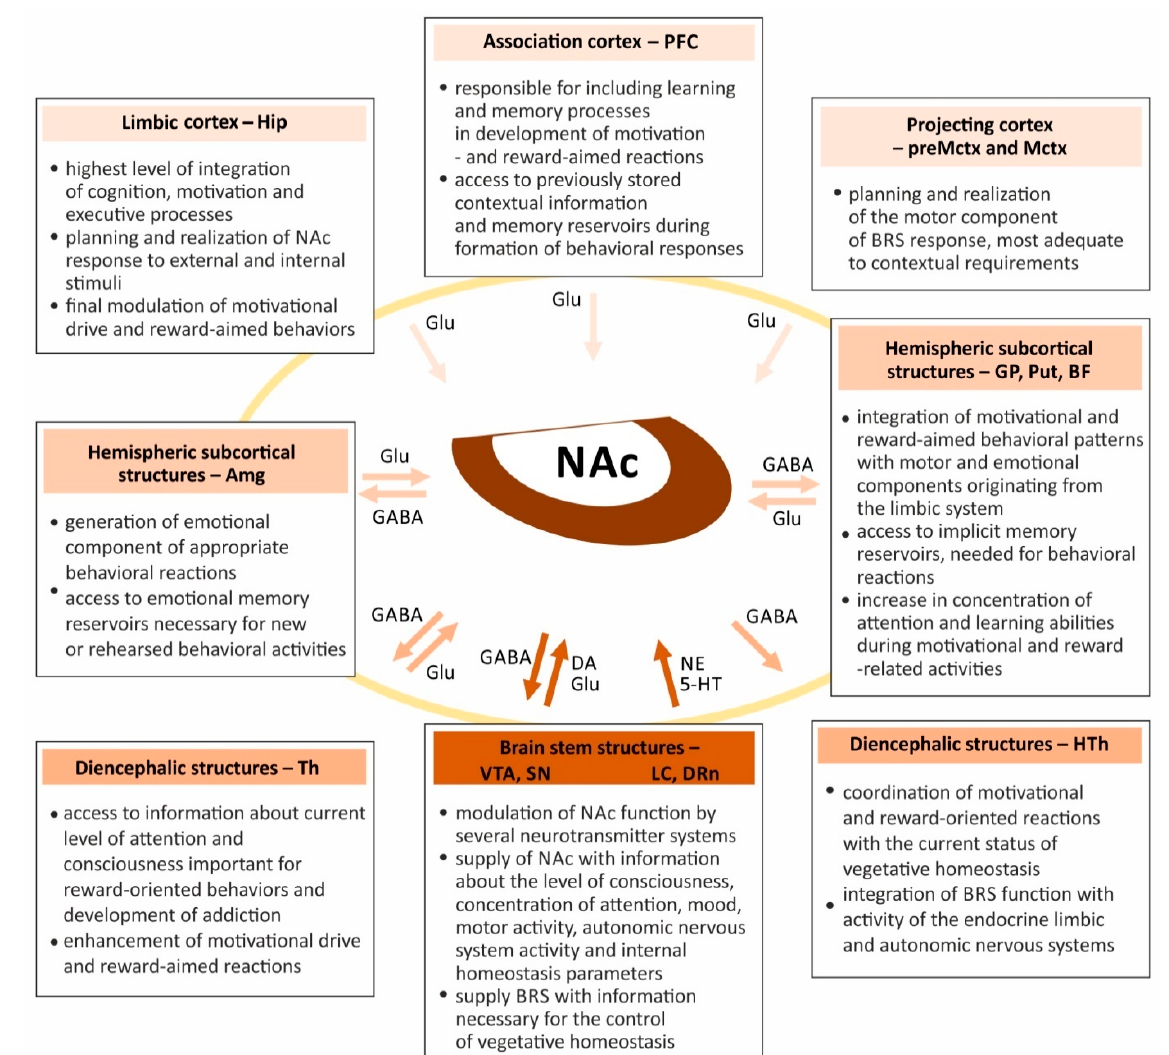
Figure 3. Functional significance of the nucleus accumbens connections. The hierarchical arrangement of NAc connec- tions with cortical, hemispheric subcortical, diencephalic, and brain stem structures illustrates its involvement in the activation of different functional systems and explains the NAc’s integrative and coordinative role on different functional levels. NAc has connections with the fields of association, projection and limbic cortices. This enables conscious and precise planning of behavioral activity based on integration of multimodal information (association cortex), along with planned and consciously performed locomotor activity (projecting cortex), and information coming from the declarative (explicit) memory reservoirs (limbic cortex). Afferent connections of NAc with the hemispheric subcortical structures transfer information from the areas responsible for creating emotional reactions (Amg), locomotor coordination (GP and Put), and from those related to increase in the concentration of attention and learning ability (BF). They also allow the use of data stored in the reservoirs of emotional and procedural (implicit) memory (Amg and basal nuclei, respectively). Af- ferent connections of NAc with the diencephalon structures, on the one hand, allow the inflow of information about the current state of consciousness and concentration of attention (Th). They allow coordination of the NAc’s activities with the endocrine system, activation of the autonomic nervous system, and metabolic processes (HTh). The NAc’s connections with the brain stem structures, due to the involvement of several neurotransmitter systems, ensure the precision of their regulation and functioning. These connections allow transfer of information about the state of consciousness and attention (VTA and LC), motor activity (SN), mood (DRn), and physiological homeostasis (LC). The multilevel system of the NAc connections with the other brain areas is based on a dynamic balance between the stimulatory and inhibitory effects of numerous neurotransmitters and modulators.